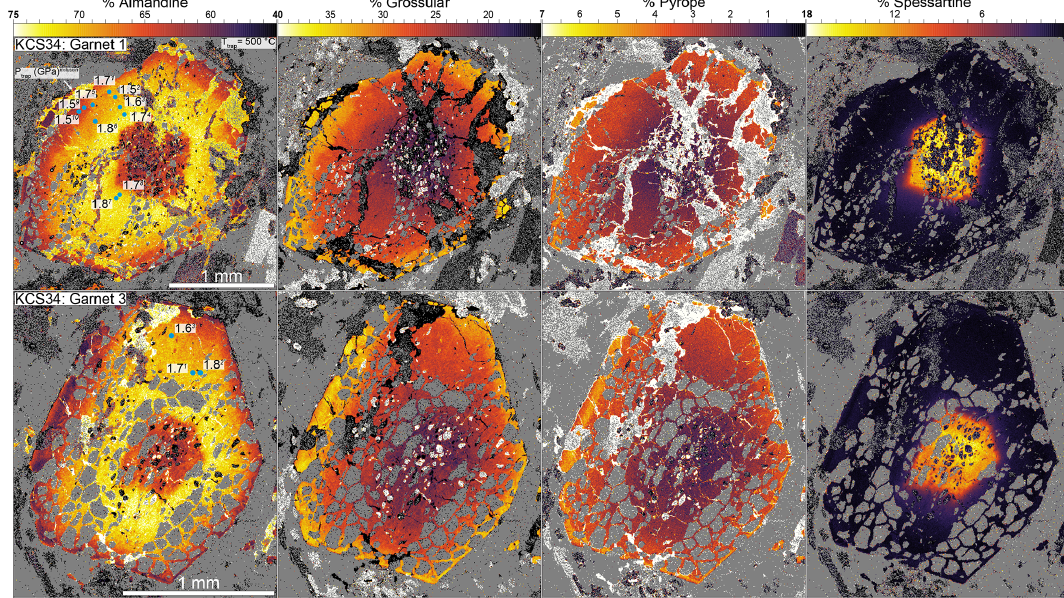
Figure 6. Compositional X-ray maps of two garnets from sample KCS34 (Delfini). Blue dots indicate the location of measured inclusions; systematic P trap differences are not observed across garnets ( P trap units are GPa, calculated at T trap = 500 ◦ C). Subscripts indicate the inclusion number (see Table